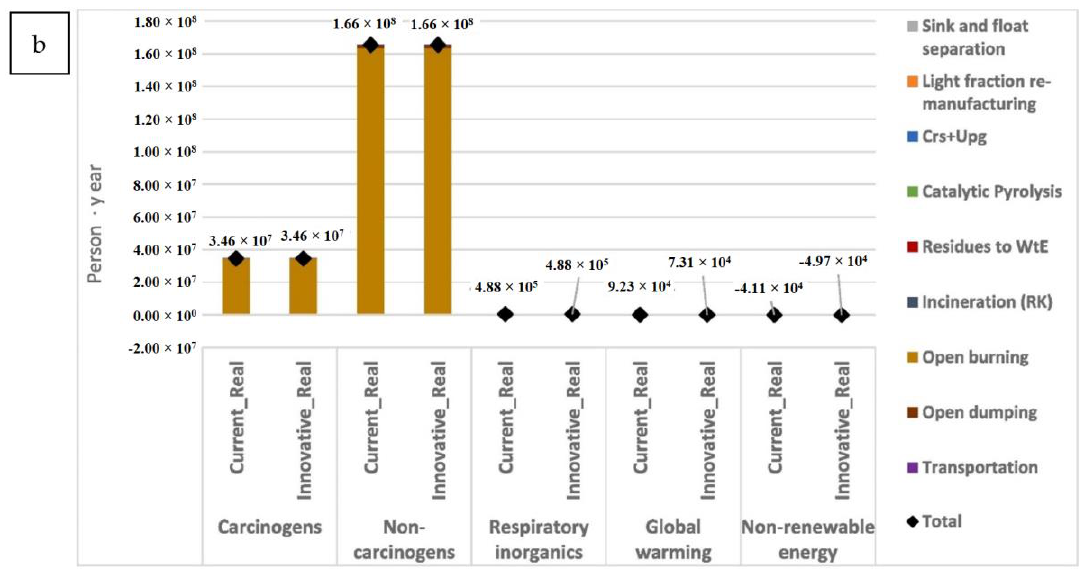
Figure 33. Normalized impact assessment data for the analyzed ( a ): Ideal and ( b ): Real scenarios concerning the functional unit and with the contribution of every single stage of the life cycle: Crs = CreaSolv ® ; Upg = Plastic Upgrading; Pyr = Catalytic Pyrolysis. The intermediates represent the current scheme where innovative processes are gradually added. The shaded rhombus indicates the total value for each impact category. Results are normalized in “Person · year” , i.e., the average impact in a specific category caused by a person during one year in Europe. Reprinted with permission from ref. [92].